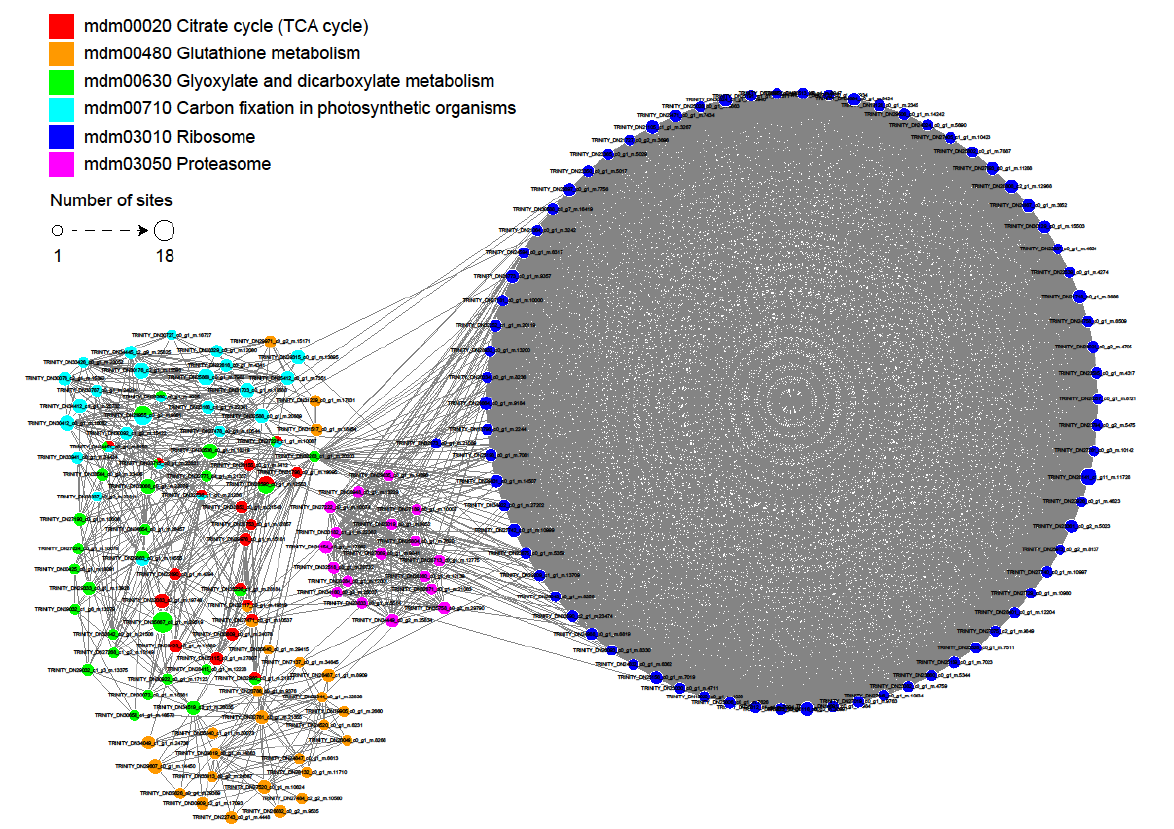
Figure 6. Interaction networks of the crotonylated proteins in paper mulberry.